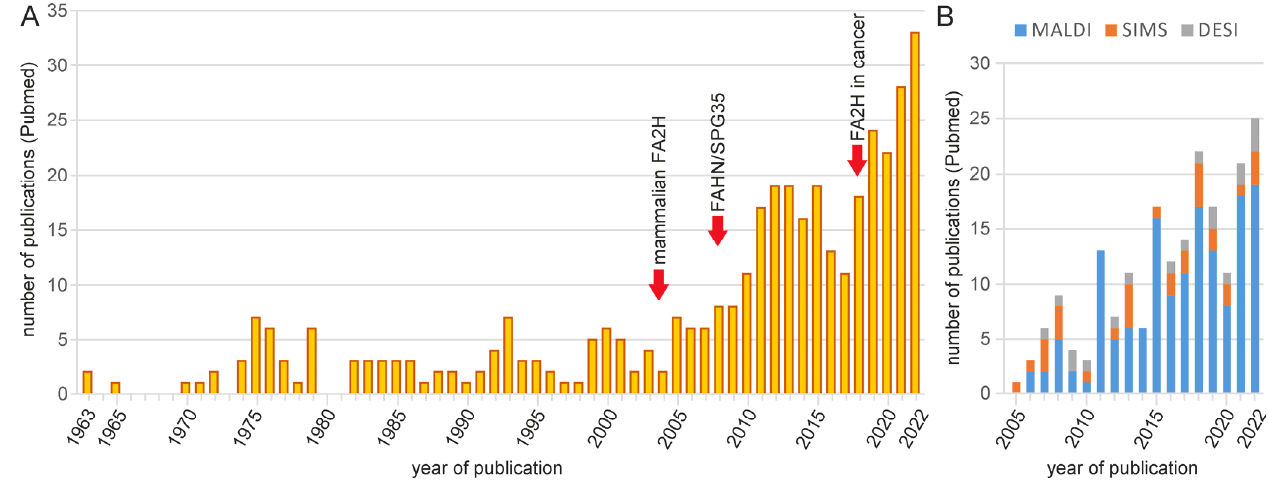
Figure 1. Number of publications dealing with 2hFA-SL and mass spectrometry imaging of sphingolipids listed in Pubmed. ( A ) Number of publications per year related to FA2H and 2-hydroxylated sphingolipids. The increase over the last 15 years was likely driven by the identification of the mammalian FA2H gene (in 2004/2005), the description of human FAHN/SPG35 disease (since 2008) and a likely role of FA2H in tumor progression in several cancer types (since 2018). Pubmed (https://pubmed.ncbi.nlm.nih.gov/; accessed on 14 February 2023) queries were performed using the following search terms: (2-hydroxyl* AND sphingo*), “2-hydroxy fatty acids”, “alpha-hydroxylated fatty”, FA2H, “fatty acid 2-hydroxylase”, “fatty acid alpha-hydroxylation”, “fatty acid hydroxylase-associated neurodegeneration” or SPG35. ( B ) Number of publications per year dealing with mass spectrometry imaging of sphingolipids (though not necessarily 2hFA-SL). The most widely used method is matrix-assisted laser desorption/ionization (MALDI), followed by time-of-flight secondary ion mass spectrometry (TOF-SIMS) and desorption electrospray ionization (DESI) imag- ing mass spectrometry. Pubmed query search terms: (MALDI OR SIMS OR DESI) AND imaging AND